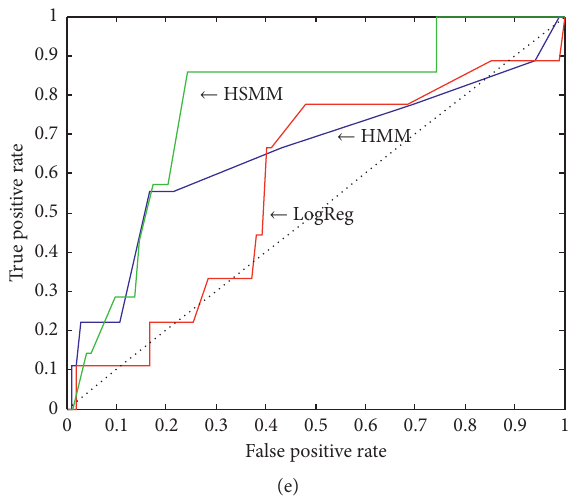
Figure 8: ROC curves for the compared prediction models: HSMM, HMM, and logistic regression. (a) Thailand. (b) Indonesia. (c) Philippines. (d) Malaysia. (e) Cambodia.